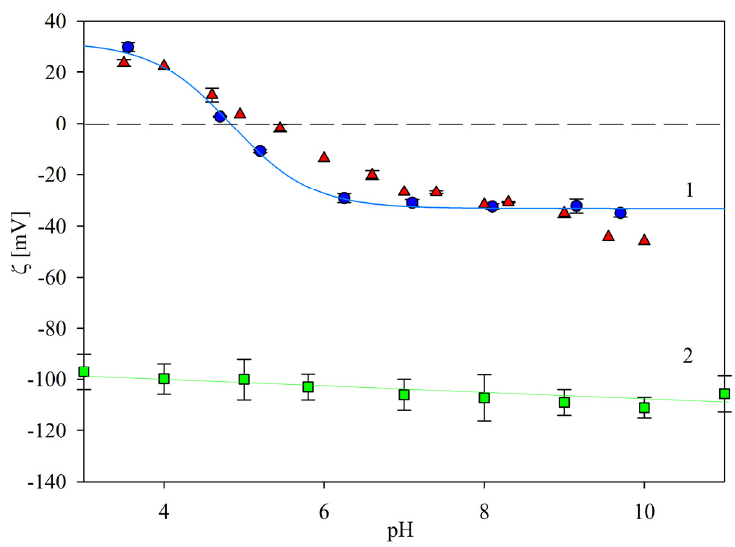
Figure 2. Dependencies of the zeta potential of the immunolatexes on pH, 10 mM NaCl; ( ● ) results for the SAL immunolatex particles in this work; solid line 1 shows the interpolation of these results. ( ▲ ): Previous results for the mouse monoclonal IgG coated immunolatex without BSA blocking, Ref. [24]. Solid line 2 shows the interpolation of the bare latex results.